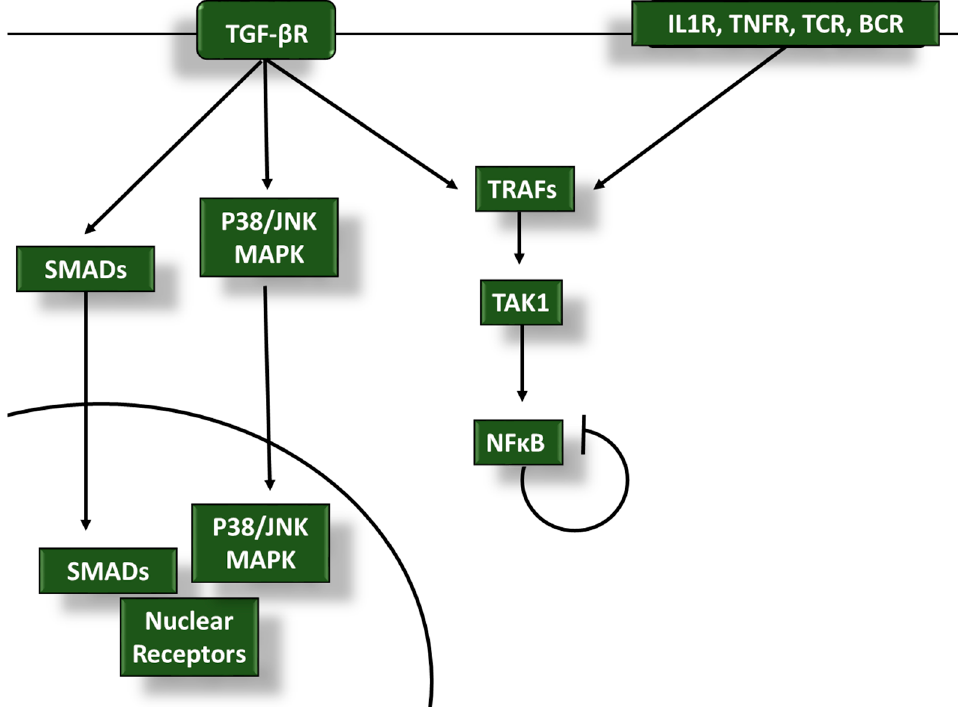
Figure 2. Transforming growth factor β (TGF- β ) dampens anti-tumor proinflammatory signaling in infiltrating leukocytes through TGF- β activated kinase 1 (TAK1), nuclear factor kappa-light-chain-enhancer of activated B cells (NF κ B), and mitogen-activated protein kinase (MAPK) modulation: tumor necrosis factor receptor (TNFR)-associated factor (TRAF) and TAK1 activity is regulated by the anti-inflammatory TGF- β receptor (TGF- β R) and proinflammatory interleukin 1 receptor (IL-1R), TNFRs, T cell receptors (TCRs), and B cell receptors (BCRs). TGF- β signaling interferes with TRAF and TAK1 activation to alter NF κ B signaling in tumor-associated leukocytes to blunt immune responses during cancer progression. TGF- β modulation of the p38/JNK MAPK pathways and SMAD activity also play a role in inhibiting proinflammatory signals.